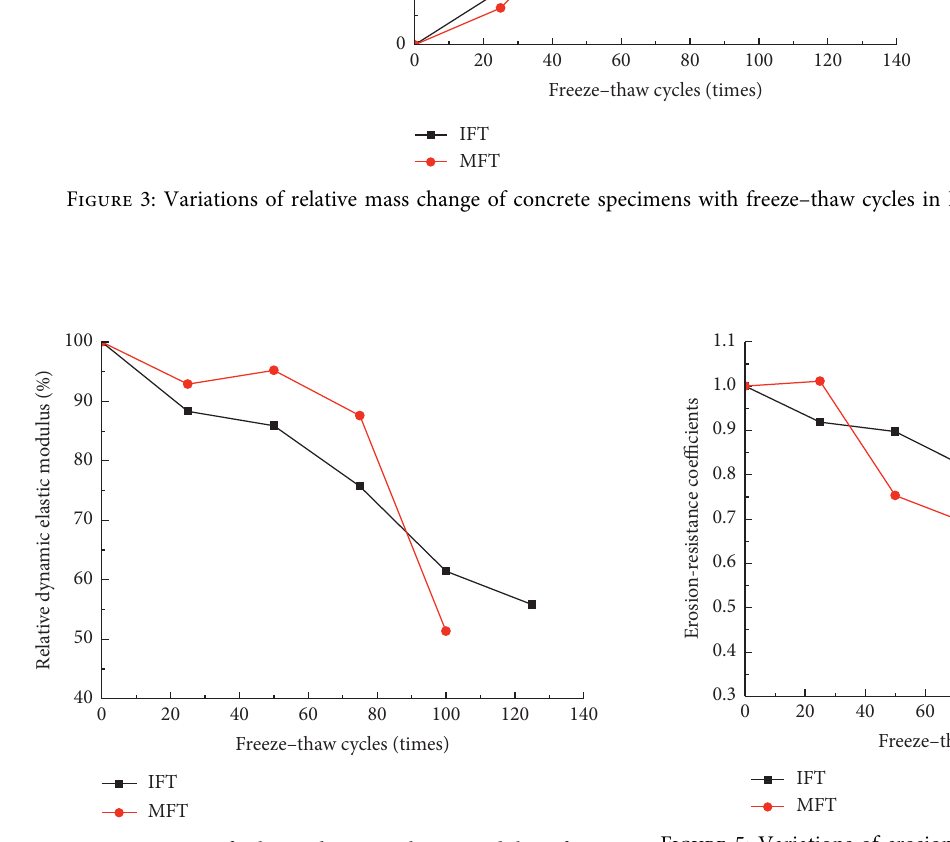
Figure 4: Variations of relative dynamic elastic modulus of con- crete specimens with freeze–thaw cycles in IFT and MFT environments.